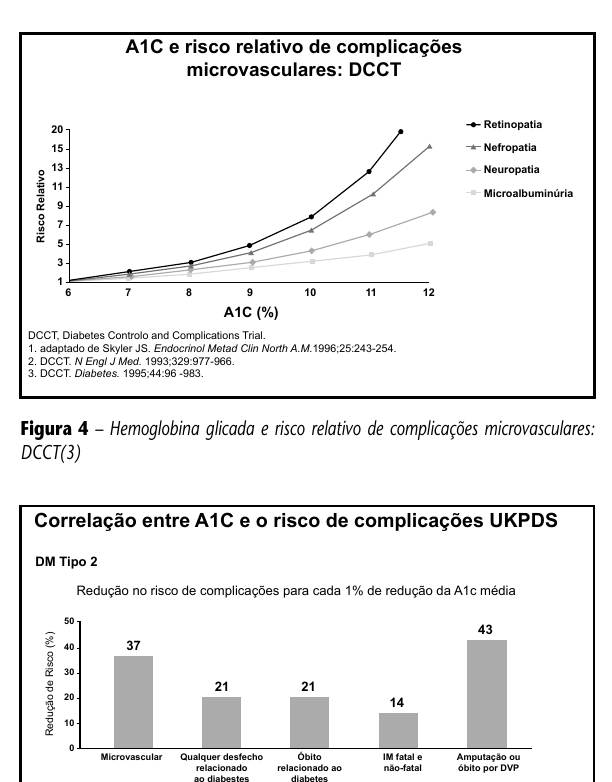
UKPDS, United Kingdom Prospective Diabetes Study: IM. infarto do miocárdio: DVP. doença vascular periférica. Stratton IM et al. Br Med J. 2000;321:405-412